Question: Name the type of graph shown.
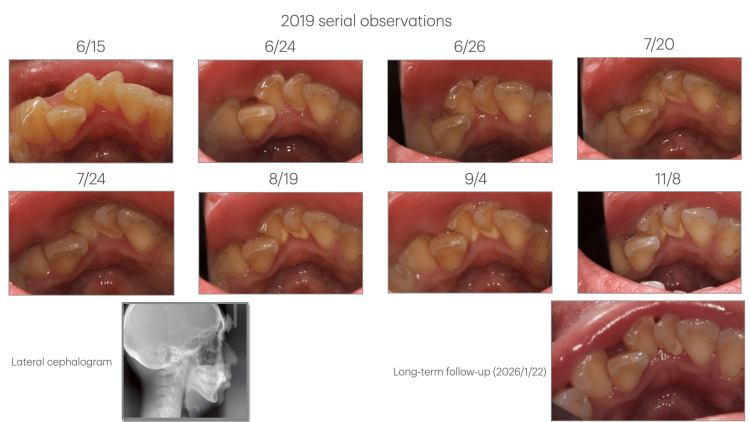
Answer: line